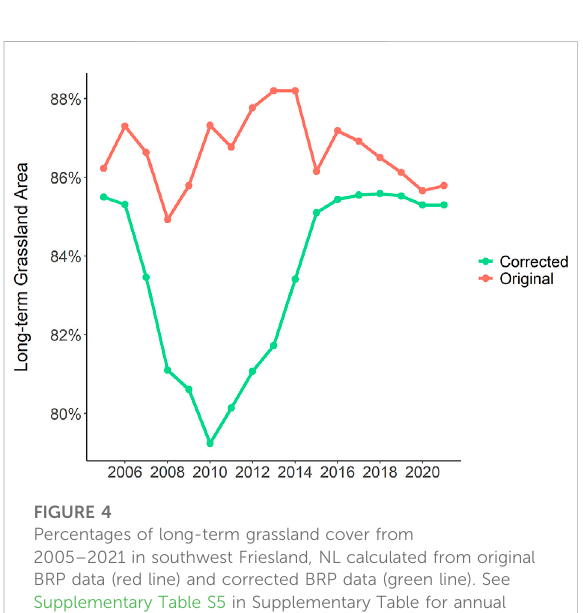
Figure S1 in Supplementary Material for full t -test results) but pH reacted signi fi cantly ( p = 0.005) with new grasslands displaying a higher range of pH. Very few plant species were found within new grasslands parcels, with only six species being the highest number identi fi ed and just a single species, L.